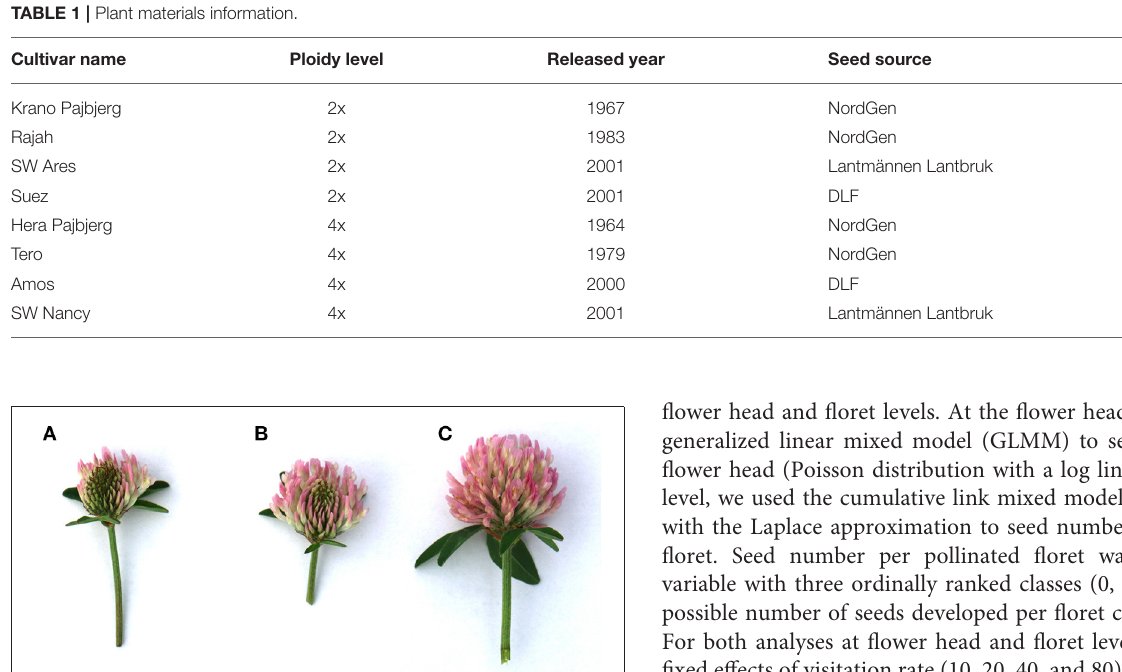
the honey bee pollination. Red clover cultivar “Amos” and “SW Nancy” were not included due to the lack of suitable flower heads after the hand pollination